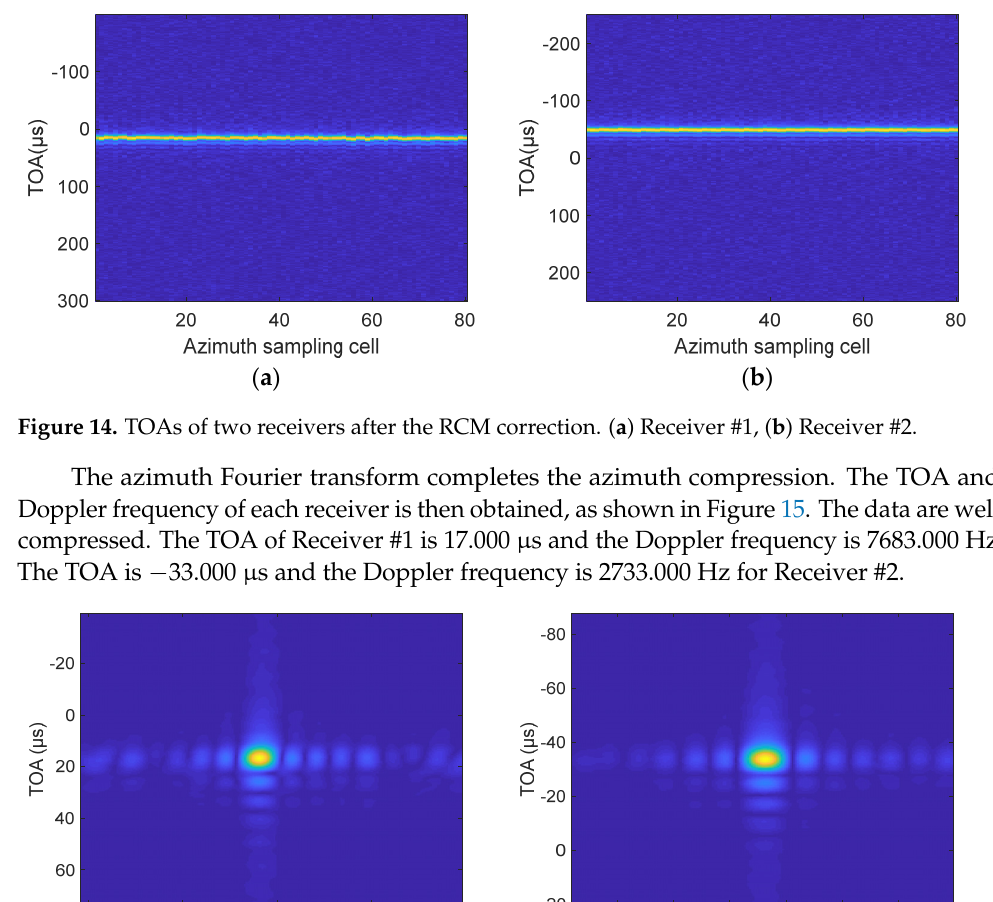
Figure 13. Compression result without the RCM correction. ( a ) Receiver #1, ( b ) Receiver #2.